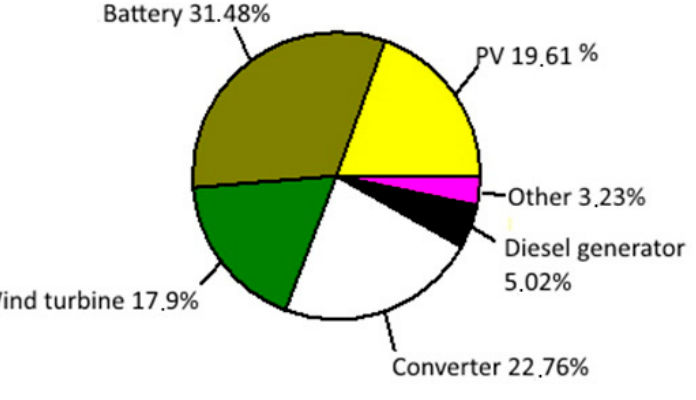
Figure 11. Cost analysis of the system.